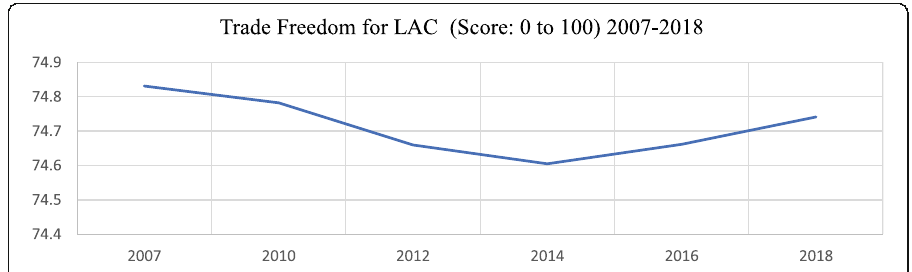
Fig. 5 LAC region Trade Freedom (TRFR) from 2007 to 2018. Source: World Bank 2021